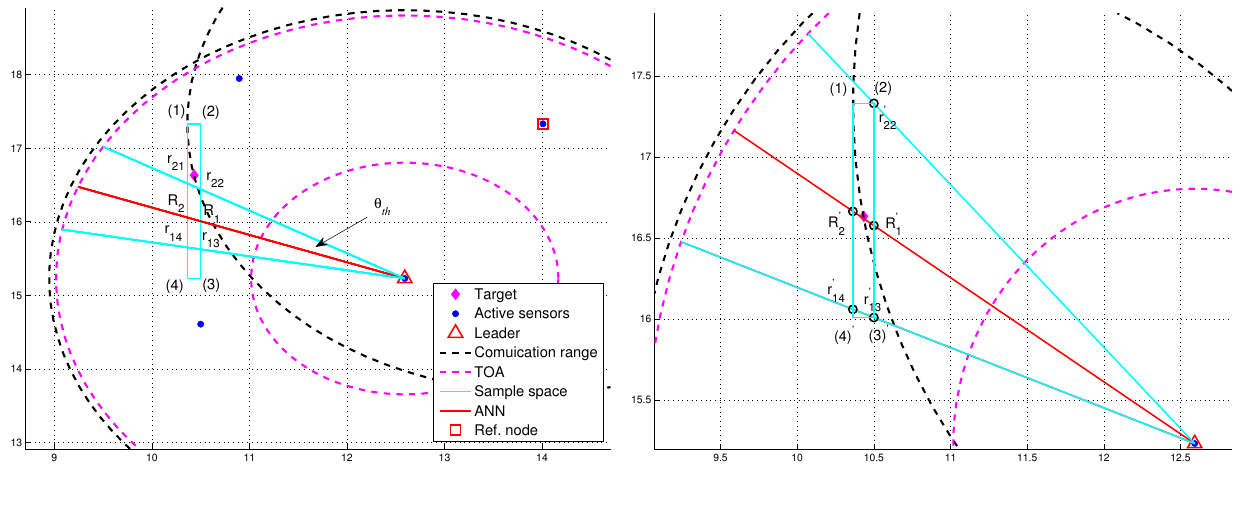
Figure 7. The original RAI ( top left ); the updated RAI ( top right ); the refined sample area ( bottom left ); the final sample area for particle filtering ( bottom right